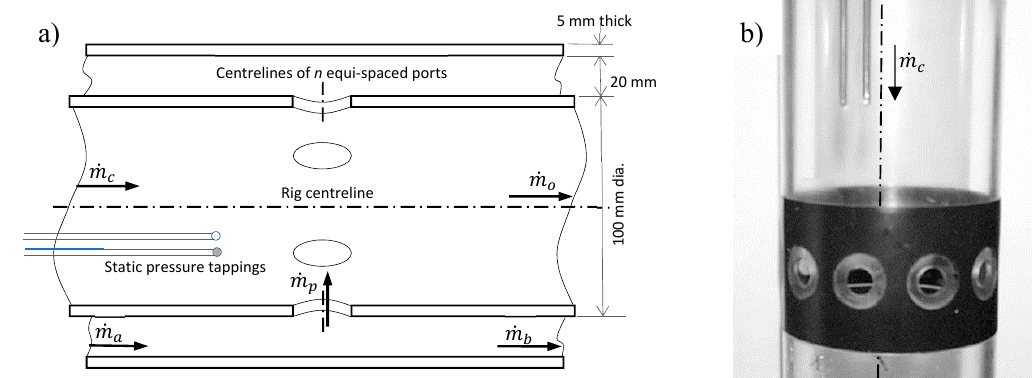
Figure 3. Waterflow test section. ( a ) schematic and ( b ) photo of inner liner with stepped ports.